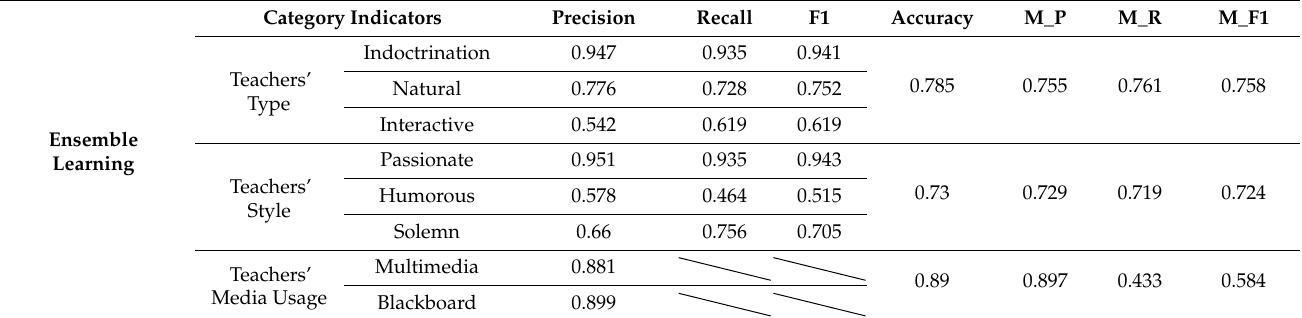
Table 10. Performance analysis for category indicators evaluated by the ensemble learning model.